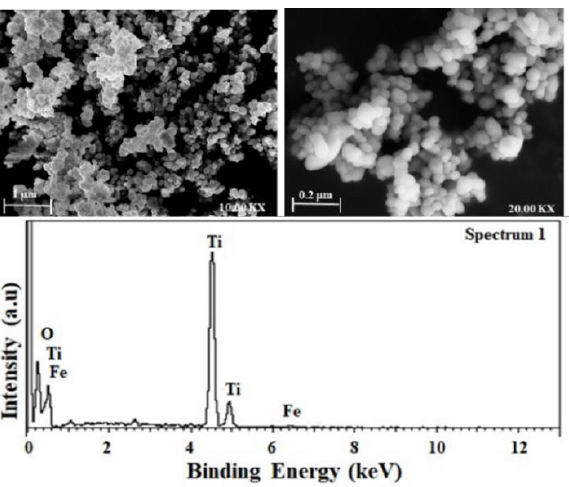
Figure 4. Scanning electron micrographs (SEM-EDX) of 0.1Fe-TiO 2 calcined at 300 °C.